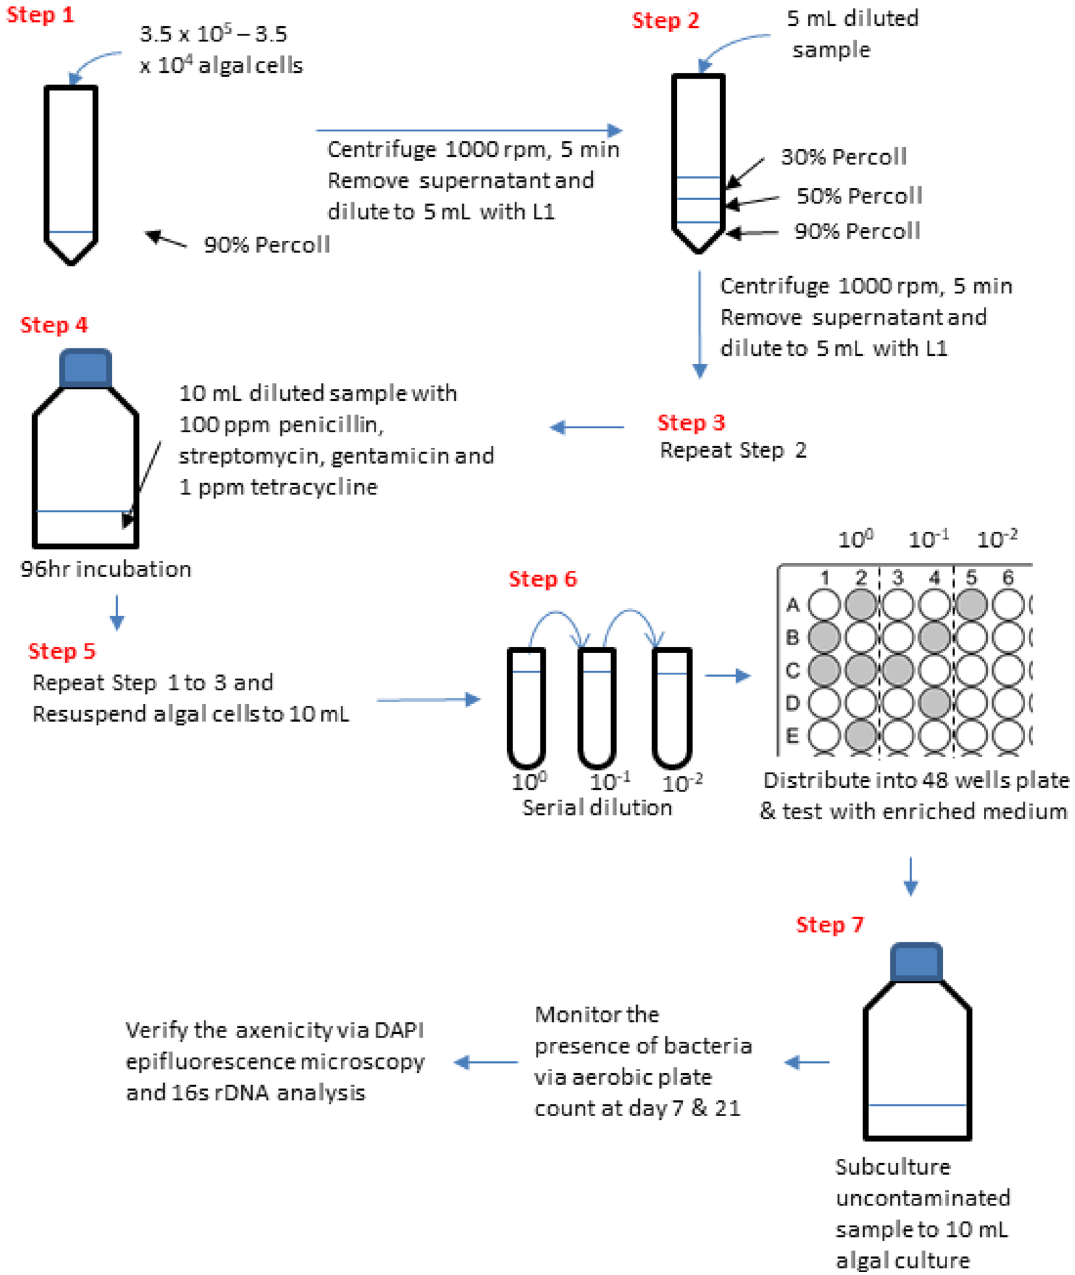
Figure 7. Workflow for establishing axenic cultures of dinoflagellate samples based on the approach demonstrated in this